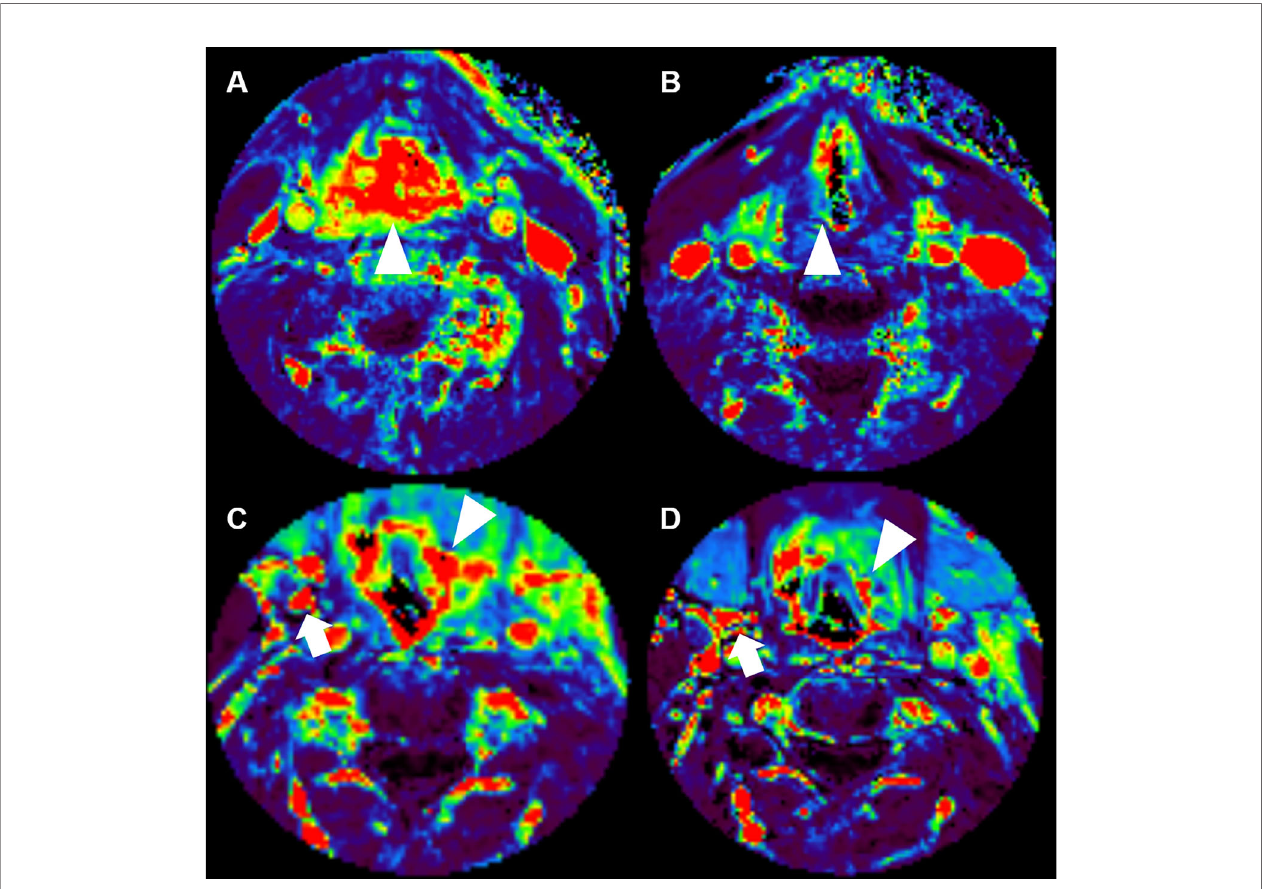
FIGURE 5 | Corresponding positive enhancement integral maps of DCE MRI for the same patients as shown in , pathologic complete response (upper row) and residual tumor (lower row) at baseline (A, C) and at follow-up (B, D) . The area of the primary tumor is marked with an arrowhead, lymph node metastasis is marked with an arrow.